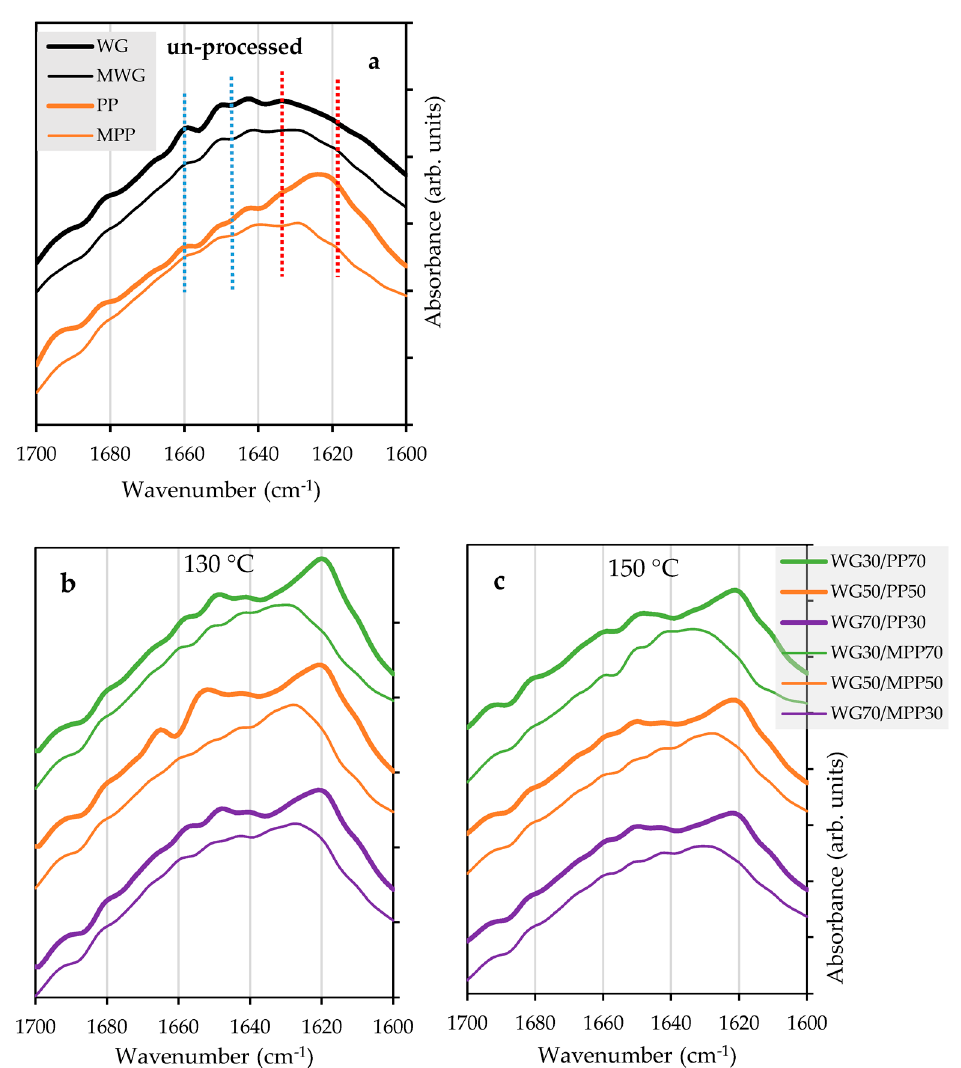
Figure 3. FT-IR spectra of individual protein powders and pressed films at 130 and 150 °C. WG, MWG, PP and MPP powders ( a ), pressed samples of WG/MPP blends along with controls ( b , c ).